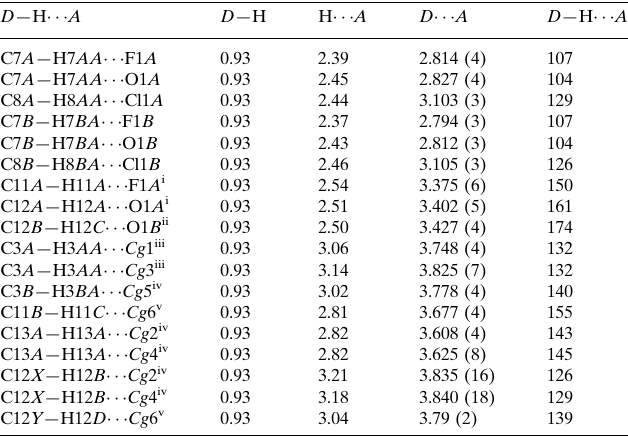
Hydrogen-bond geometry (A˚ , (cid:1)